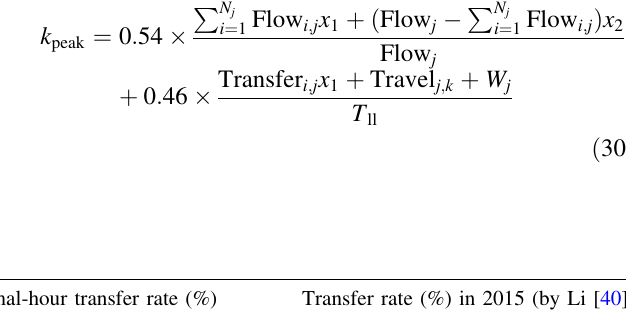
Table 4 Value of the passenger transfer rate Metro lines Peak-hour transfer rate (%) Normal-hour transfer rate (%) Transfer rate (%) in 2015 (by Li [40]) Line 4 to line 2 13 9 75 Line 13 to line 2 36 27 27 Line 2 to line 4 27 28 51 Line 13 to line 4 31 2 8 Line 2 to line 13 40 39 Line 4 to line 13 6